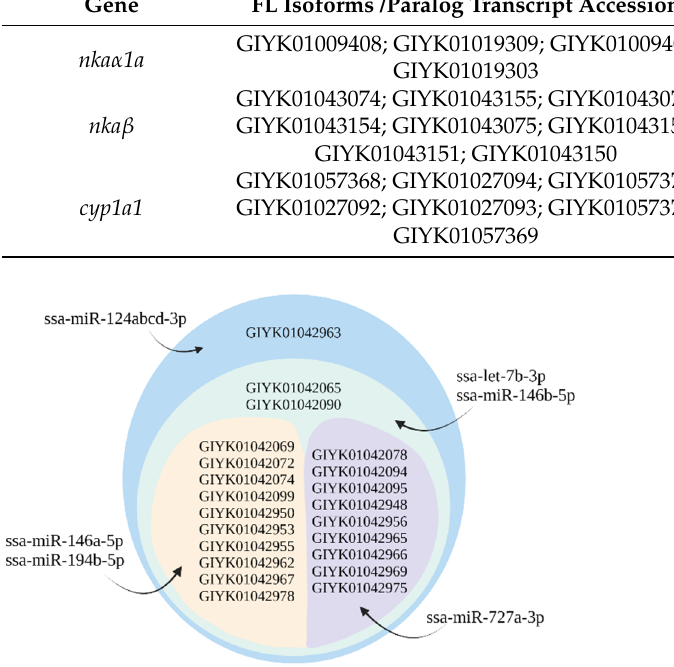
Figure 2. Six gDE miRNAs targeting particular splice variants of nkaα1b (22 isoforms). Ssa-miR-124abcd-3p was predicted to target all the splice variants shown in all the circular layers, while ssa-let-7b-3p and ssa-miR-146b-5p targeted transcripts belonging to the second and inner layers. Ssa-miR-146a-5p and ssa-miR-194b-5p targeted only the splice variants in the left inner layer, while ssa-miR-727a-3p targeted only the transcripts in the right inner layer.